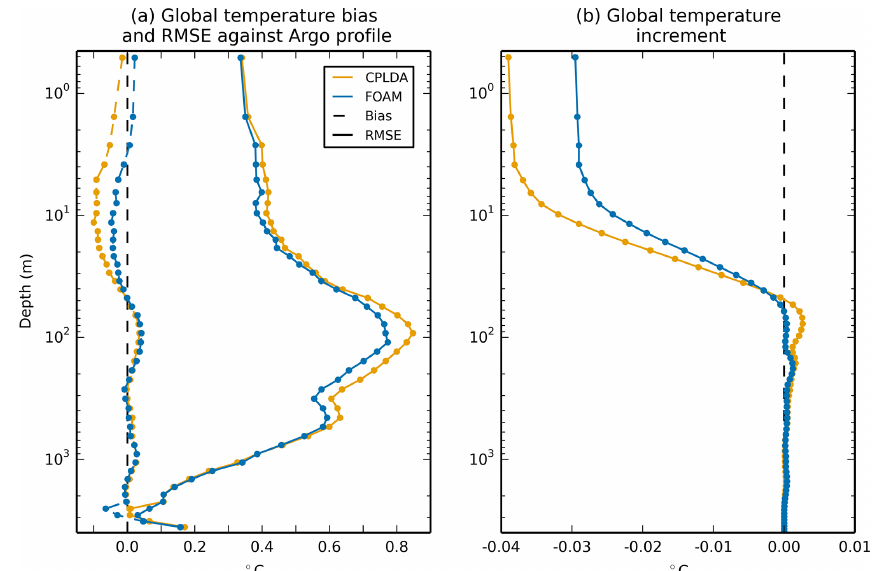
Figure 7. (a) CPLDA and FOAM global average mean bias and RMSE temperatures compared to Argo observations using class 4 method- ology; (b) global average mean temperature increments applied in CPLDA and FOAM.